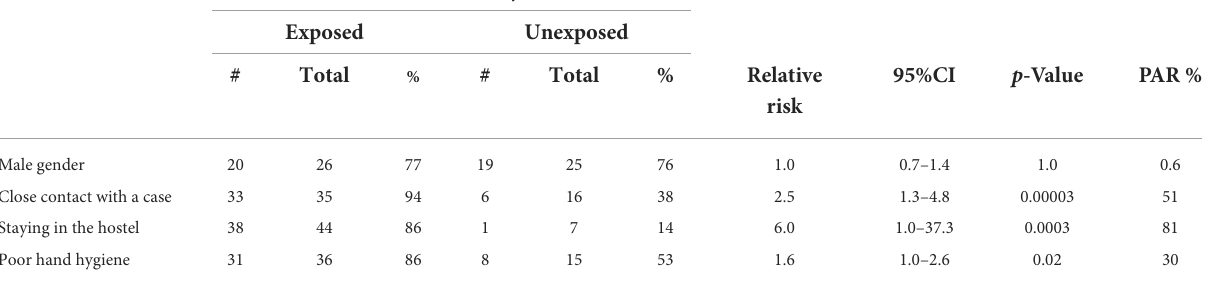
TABLE 1 Attack rate of acute conjunctivitis by different exposures among the students and staff of a visually-impaired school, Tamil Nadu, India, Jan–Feb 2020. Attack rate of acute conjunctivitis Exposed Unexposed #